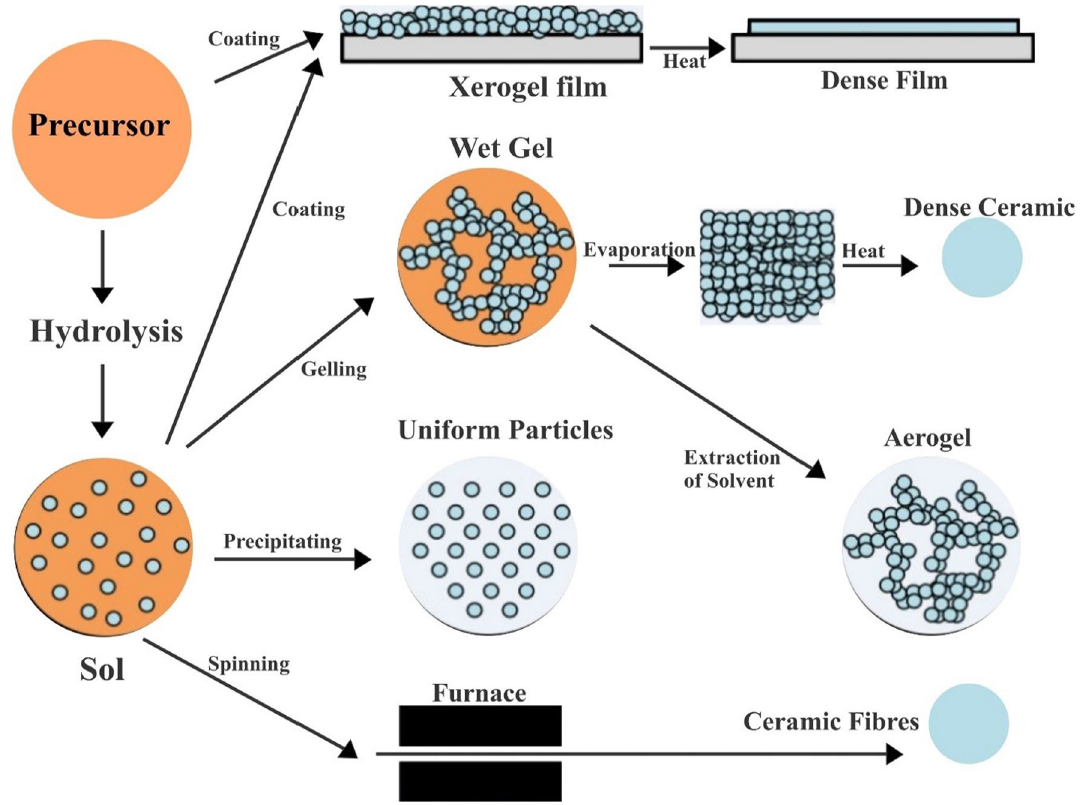
Fig. 2 Different stages and routes of the solgel